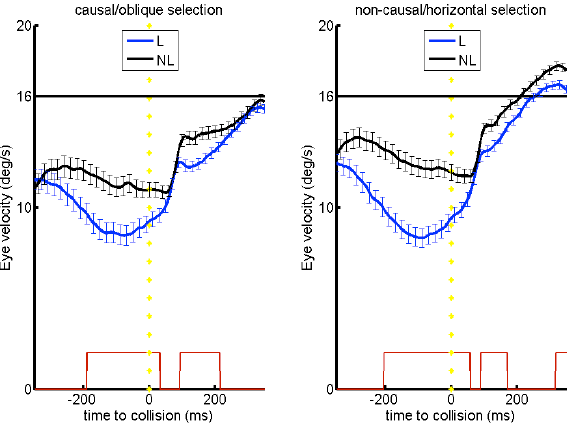
Figure 4. Smooth pursuit average velocities over time per target selection. Graphs show vectorial eye velocity per target selection (Left plot shows causal/oblique target selections, right plot shows non-causal/horizontal selec- tions). Condition is color coded (Blue lines indicate Launching, black lines indicate No-Launching). Bars indicate standard deviation of average pursuit velocity per 10ms for all subjects. The bottom thin red line indicates significant differences (Ranksum-test with Bonferroni correction,